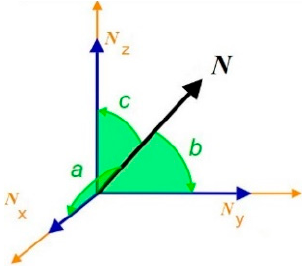
Figure 4. Directional angles of the normal vector.